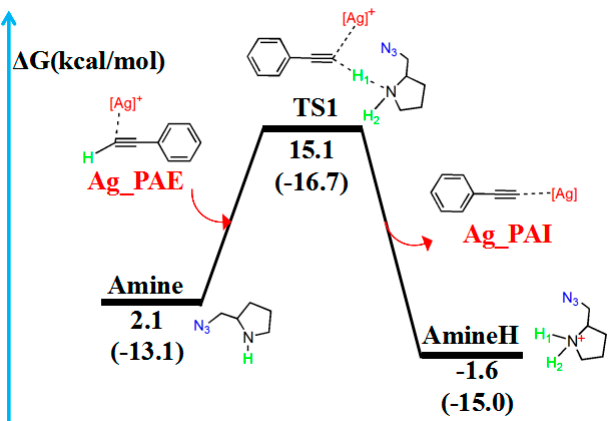
Figure 3. Reaction pathway of the hydrogen migration reaction involving amines. The relative free energy of the reaction pathway involving hydrogen is provided in kcal/mol. The relative enthalpy is also provided in brackets for reference (in kcal/mol).